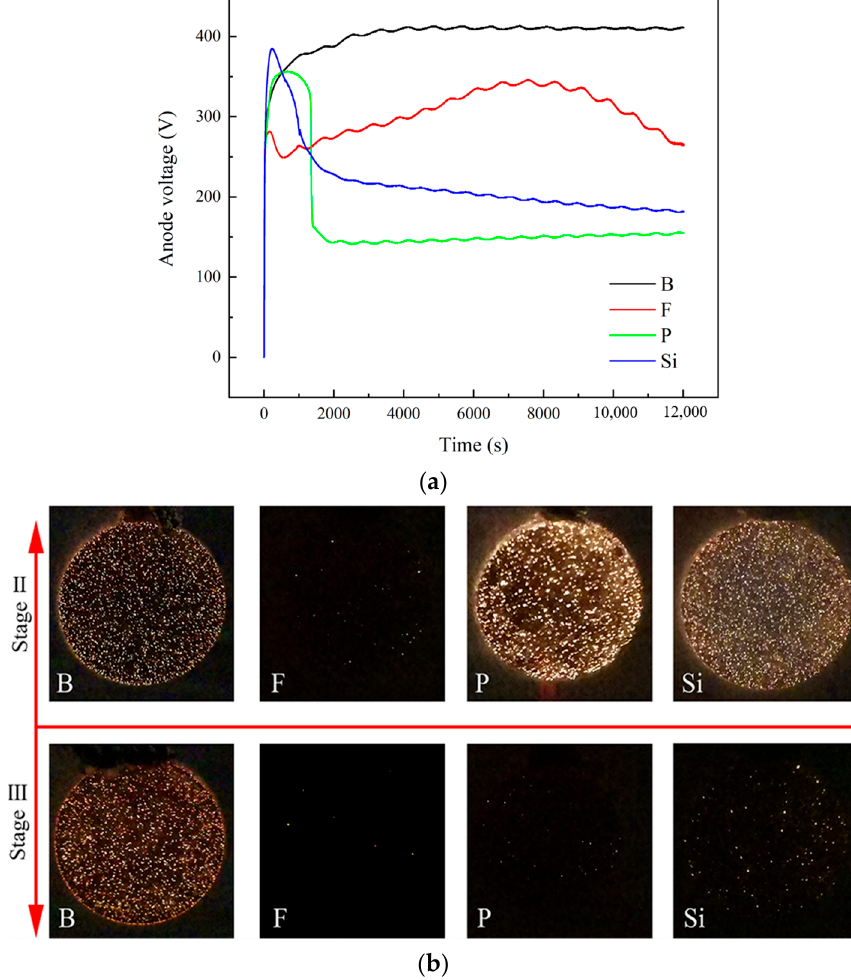
Figure 2. ( a ) Voltage–time response of the anode and ( b ) the morphologies of the discharge spark at stages Ⅱ and Ⅲ in different electrolytes.